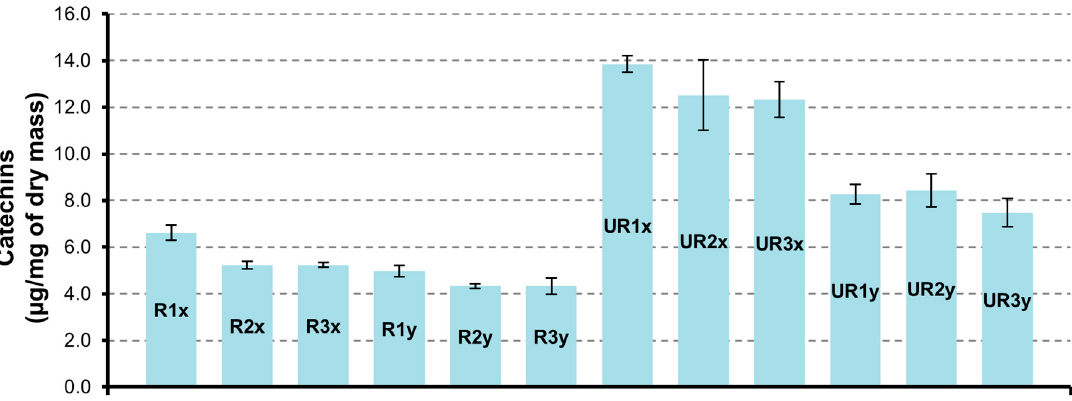
Figure 2. Catechins quantification in CAR-R and CAR-UR extracts; 1 (24 h), 2 (48 h), and 3 (72 h) time of drying; x (3 h) and y (6 h) time of extraction.